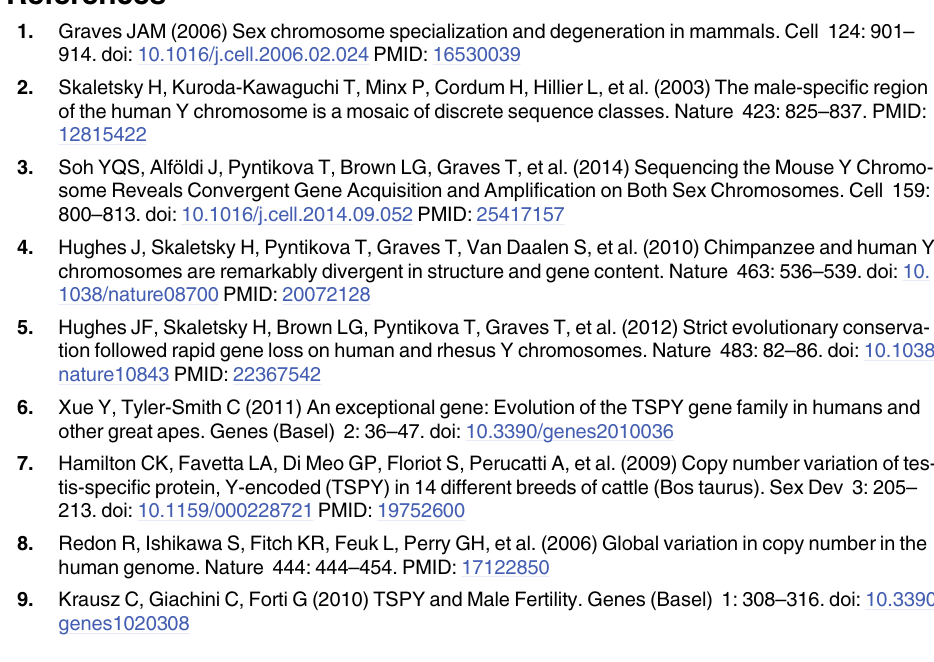
S1 Table. Primer and probe sequences, annealing temperature, product sizes and primer efficiencies. Efficiency values determined from either STD curve or as the average of individual LinRegPCR efficiencies. S2 Table. TSPY CN at three exons by qPCR in 20 boars. At each exon calculations were made using two different primer efficiencies, as determined from either STD curve or as the average of individual LinRegPCR efficiencies (XLSX) S3 Table. TSPY ddPCR CN ratios at three exons in 20 normal, 5 Low- and 5 High-fertility boars. Direct Boar Effect (DBE) values are included where available.